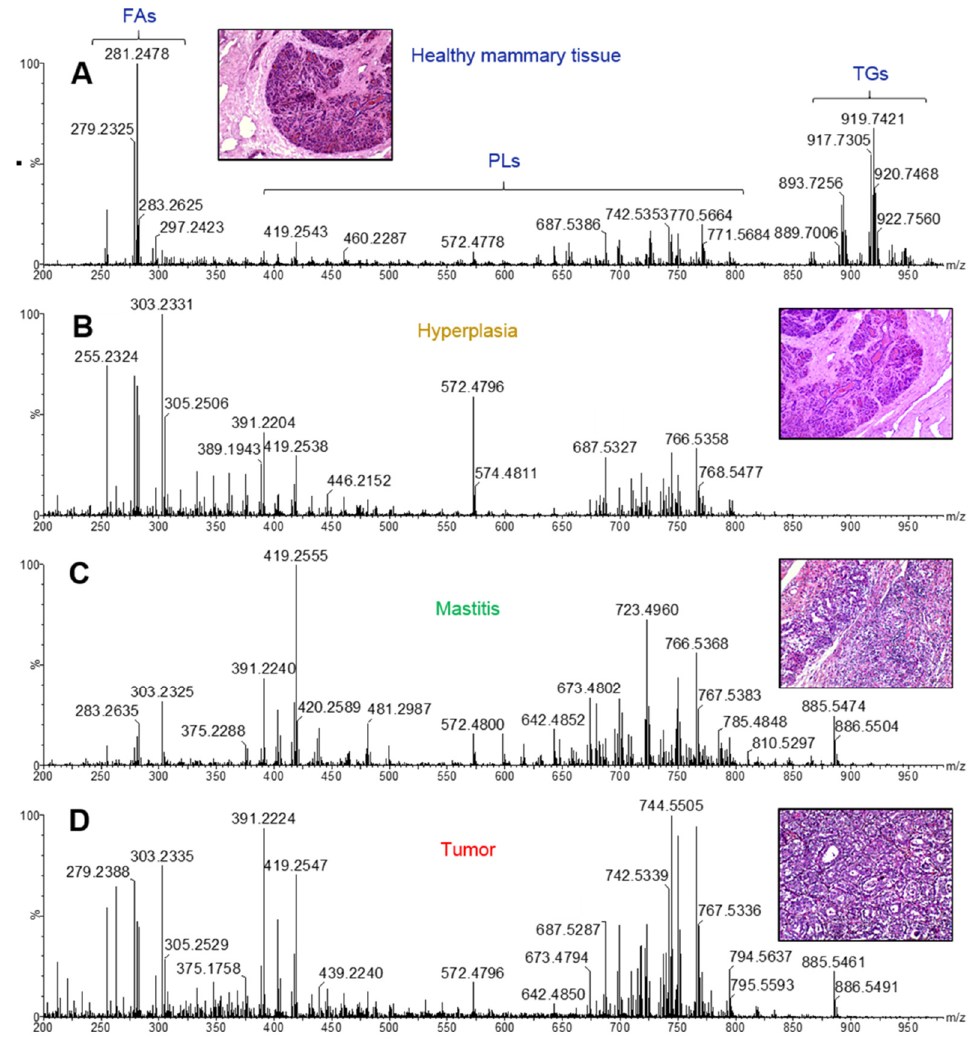
Figure 4. Representative REIMS(-) spectra of ( A ) healthy mammary gland, ( B ) hyperplastic/dysplastic tissue, ( C ) mastitis, ( D ) tumor.